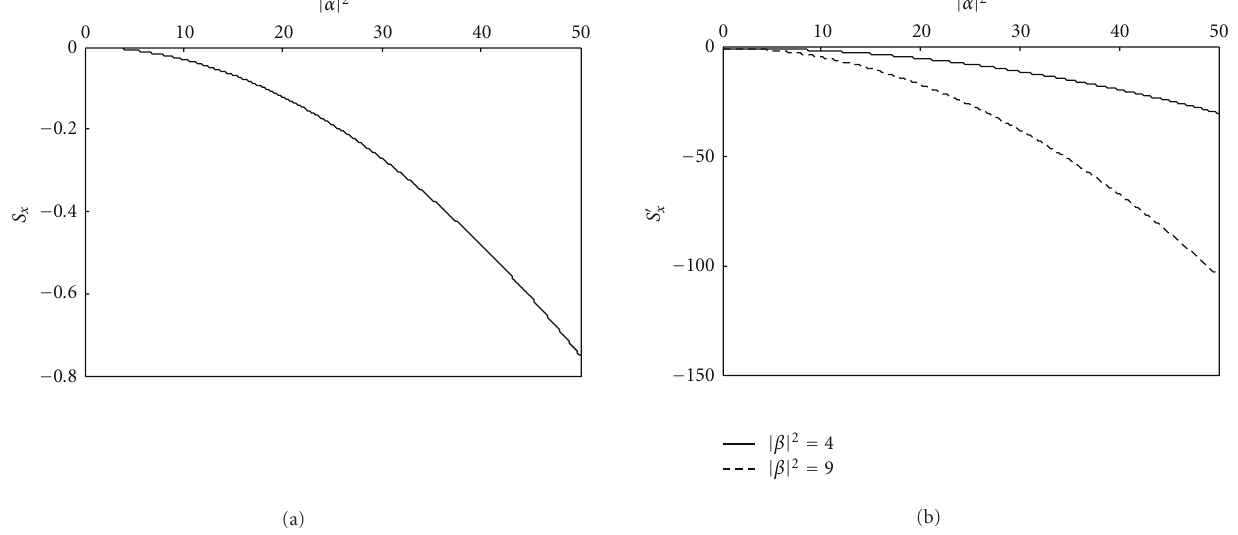
Figure 2: Dependence of first-order squeezing (a) s X with | α | 2 in spontaneous and (b) s (cid:6) process.